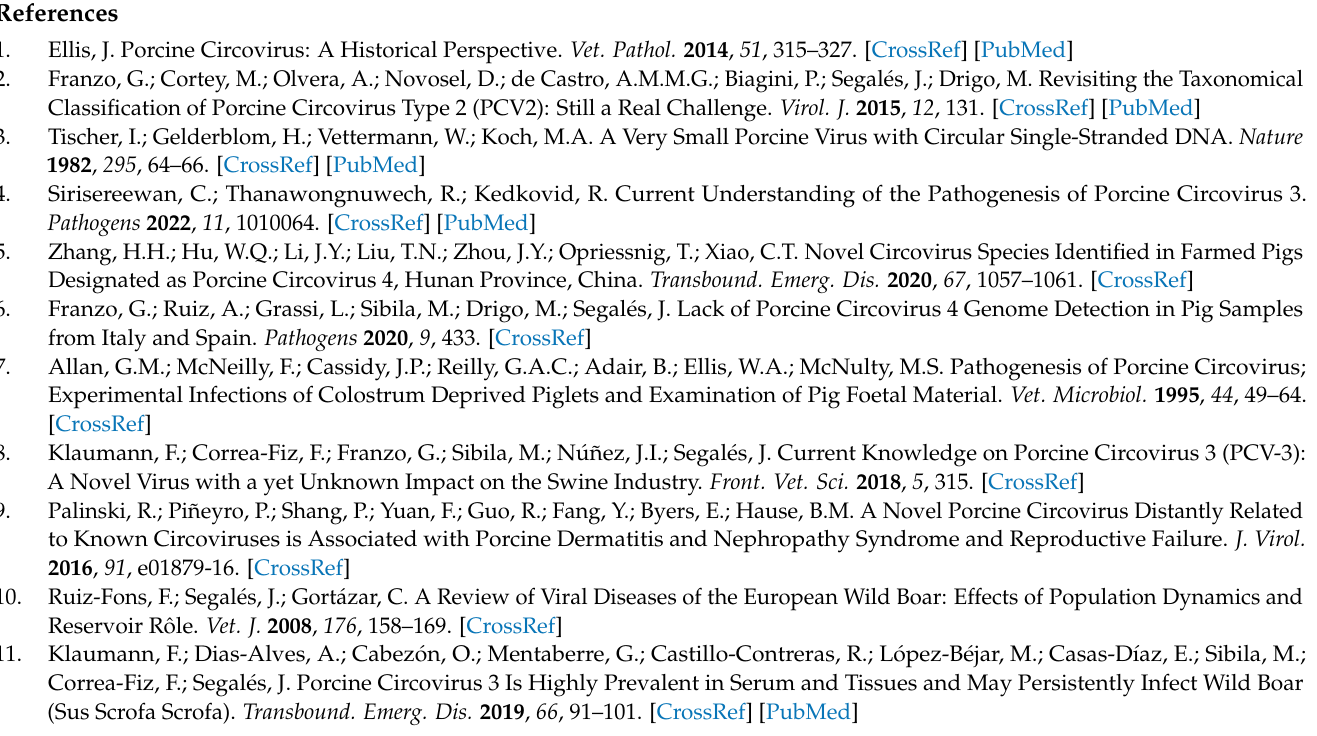
Table S2: PCV positive samples by quantitative real-time PCR; Table S3: Interrogation (BLAST) of NCBI nucleotide database (acceesed on 28 February 2022) of the partial (500nt) ORF1 (replicase) sequence of porcine circovirus (PCV) strains generated in this study; Table S4: Genomic features of complete genomes of porcine circoviruses (PCVs) sequenced in this study; Table S5: Nucleotide identity between porcine circovirus 3 (PCV3) strains based on the overall